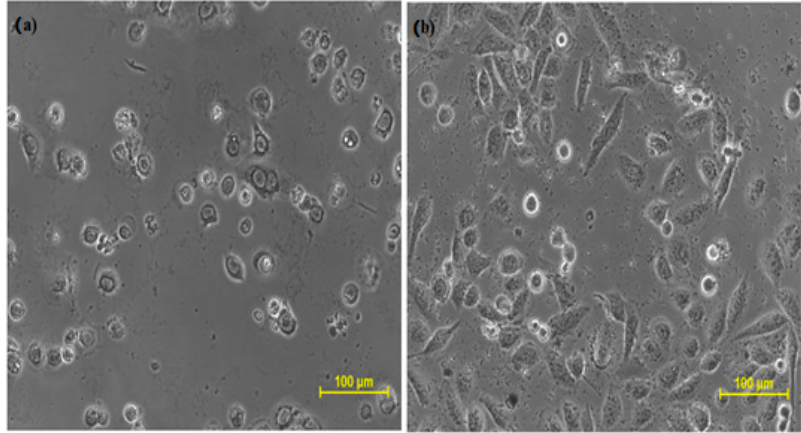
Figure 3. Cytotoxic effect of ( a ) doxorubicin and ( b ) longifolene on DU-145 cells. Table 2. MTT assay of doxorubicin and longifolene on SCC-29B. Table 3. MTT assay of doxorubicin and longifolene on Vero cell line.